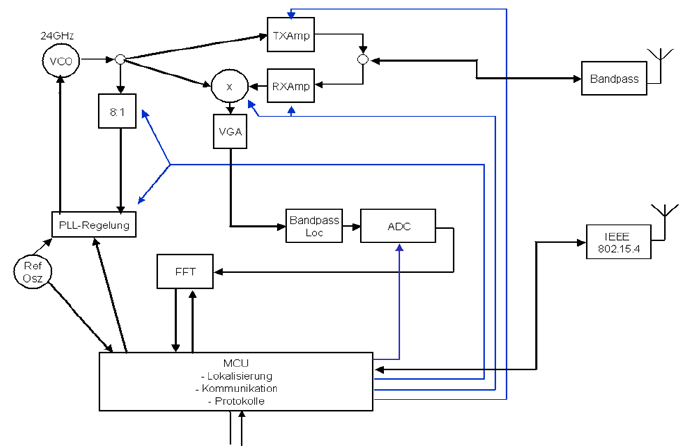
Figure 3. Schematic of the proposed 24 GHz localization system.